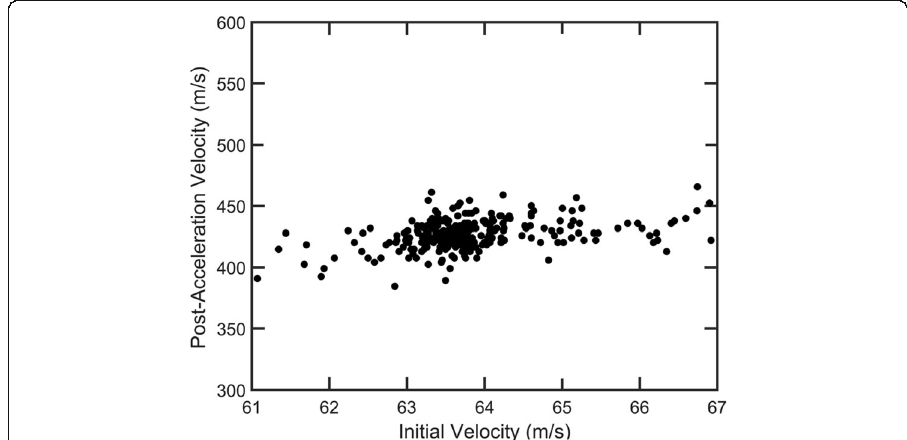
Fig. 11 Accelerated velocity distribution for 990 nm PSL particles. Initial energy-per-charge of particles is 400 eV with an acceleration potential of -2500 V on each of the 9 electrodes